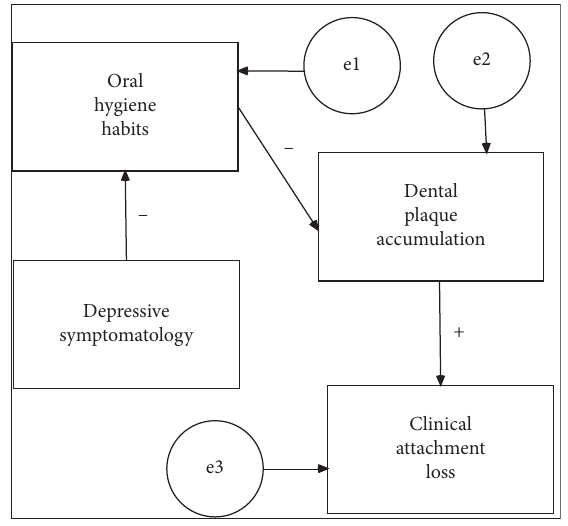
Figure 1: Hypothetical